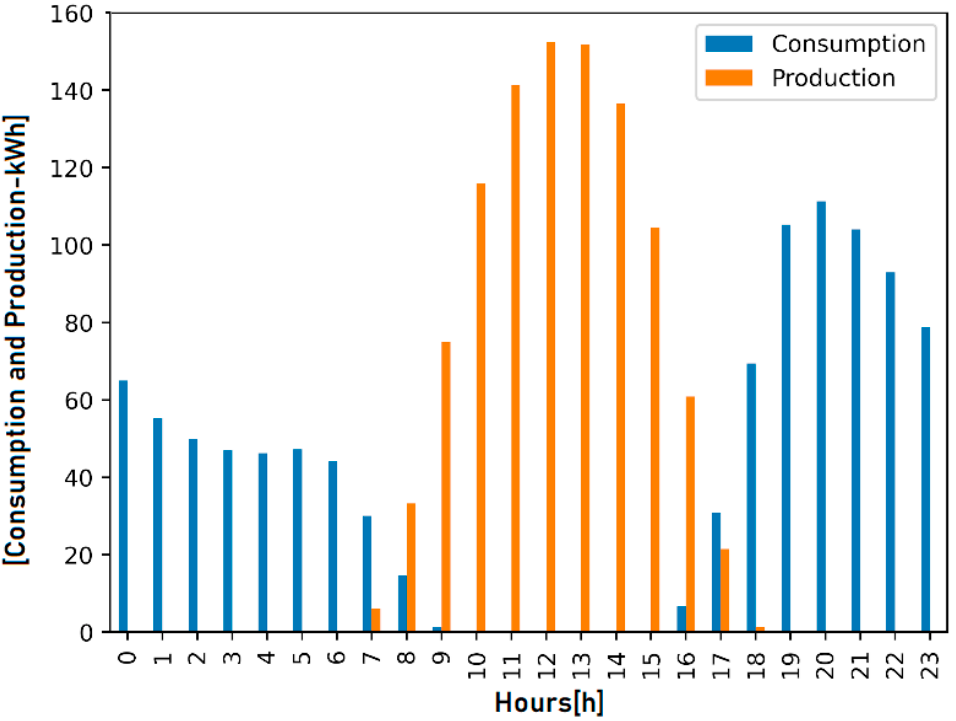
Figure 4. Annual total distributed consumption and injection over the day.